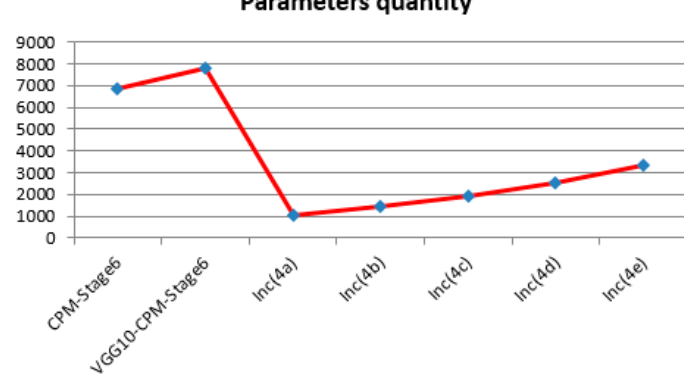
Figure 6. The parameters’ quantity comparisons of these models.